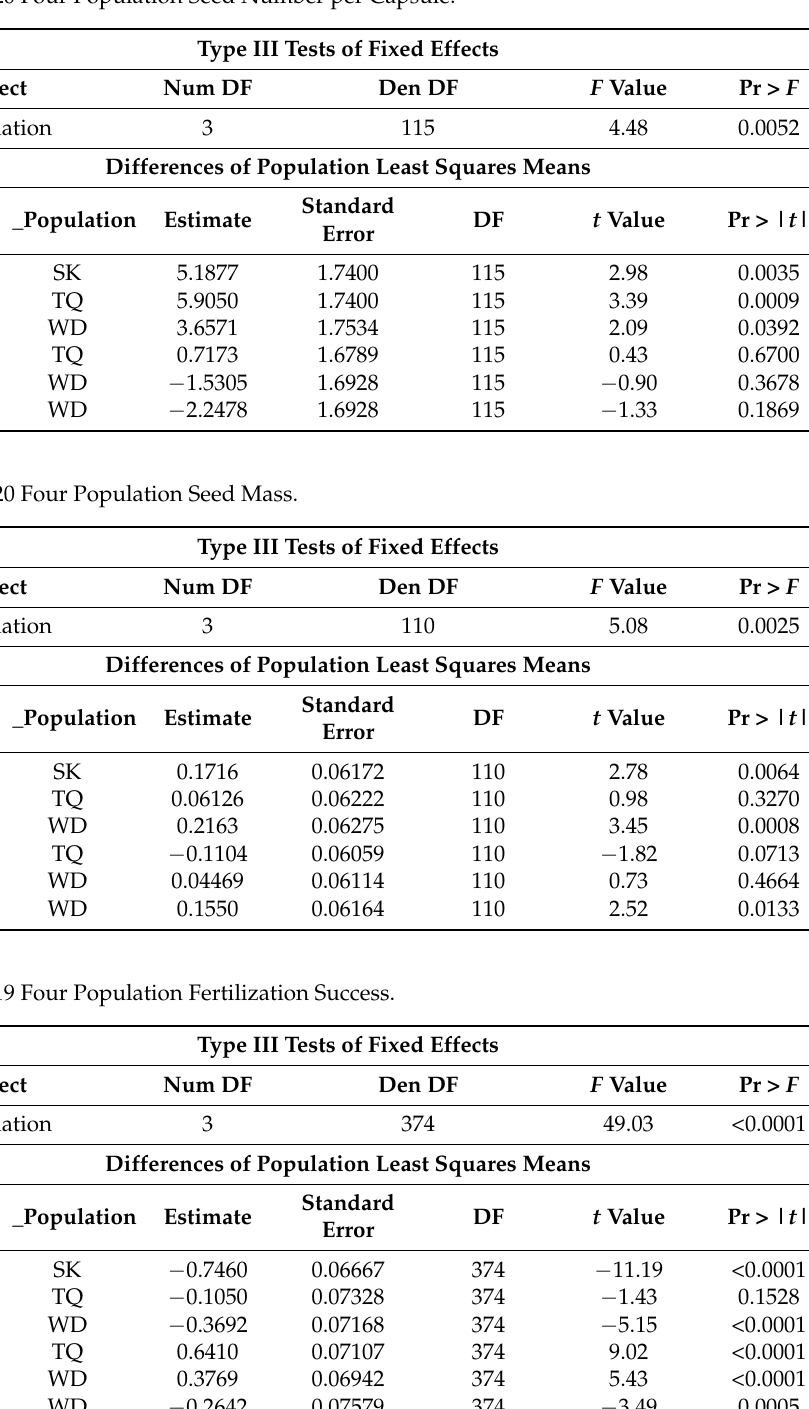
Table A11. 2020 Four Population Seed Number per Capsule.